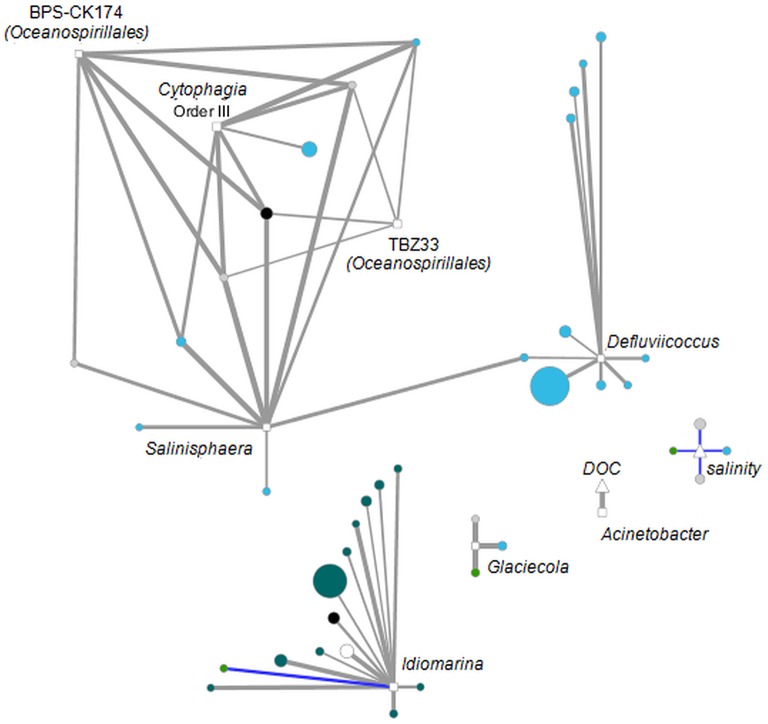
Interaction network analysis of OTUs (squares), DOM molecules (circles) and environmental parameters (triangles) that were significantly correlated (p < 0.05) with R ≥ 0.9 or R ≤ −0.9 (Table 1). Positive correlations are indicated in gray, negative correlations in blue. Line width is set proportional to correlation strength. Average OTU relative abundance and DOM molecules abundances are set proportional to node size. Nodes are colored according to DOM category. Blue, unsaturated aliphatics; Petrol, saturated fatty acids; Gray, polyphenols; Black, peptides; Green, highly unsaturated compounds; White, unspecified.